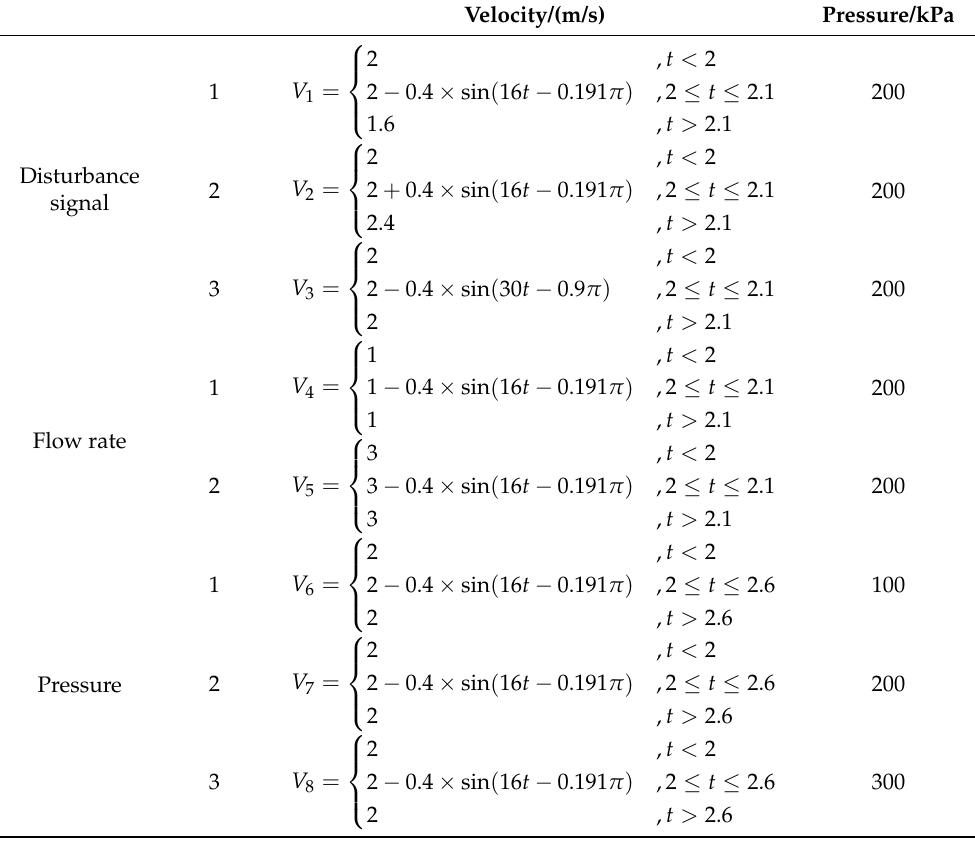
Table 2. Parameter